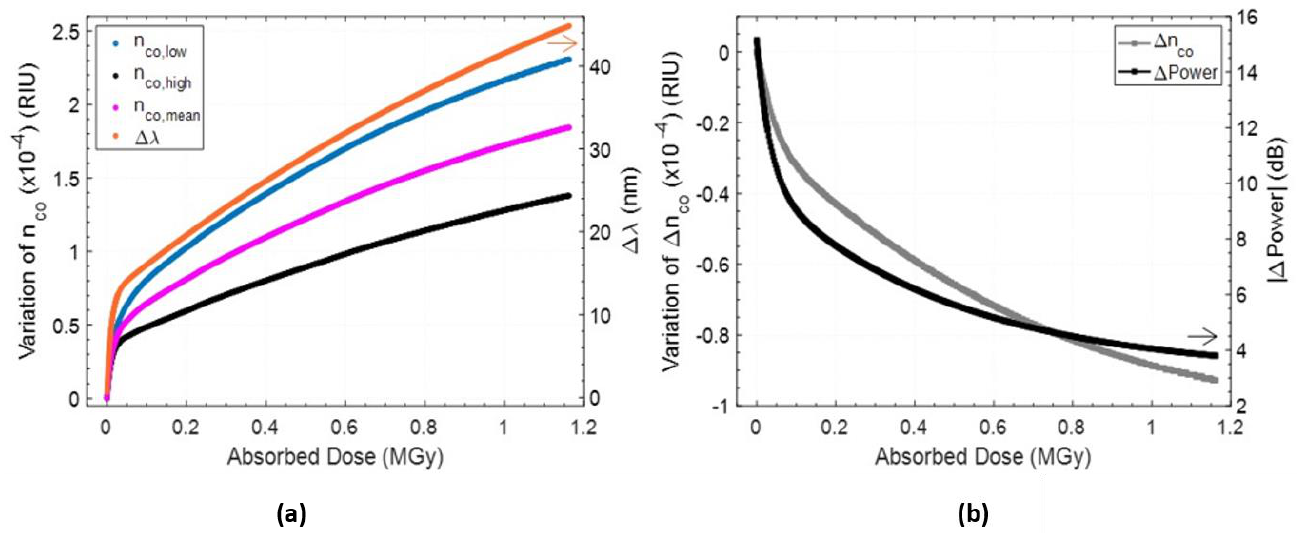
Figure 33. Variations of ( a ) n co (on the left axis) and of ∆ λ (on the right axis), ( b ) ∆ n co (on the left axis) and | ∆ Power| (on the right axis) as a function of the absorbed dose. Adapted with permission from Ref. [156] (the figure is released under a Creative Commons CC BY license http://creativecommons.org/licenses/by/4.0/ (accessed on 12 March 2023), Copyright © 2018).